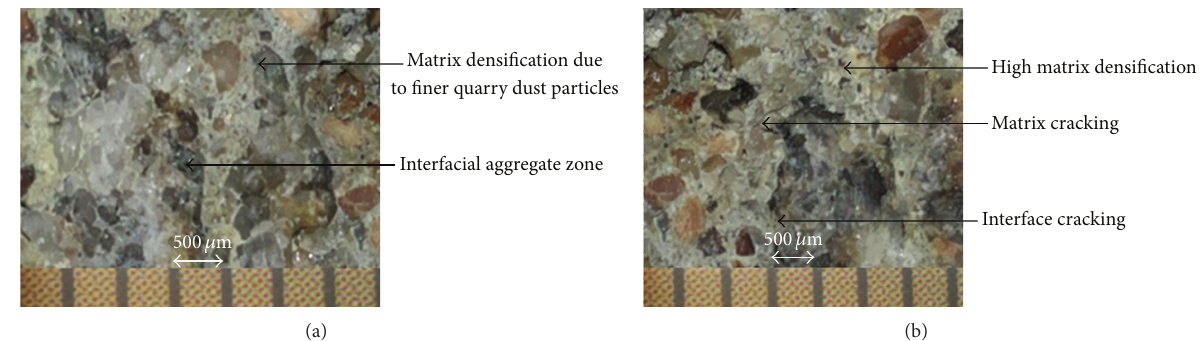
Figure 12: (a) Microscopic view of quarry dust concrete without stress (50x magnification). (b) Microscopic view of quarry dust concrete at 40% load (50x